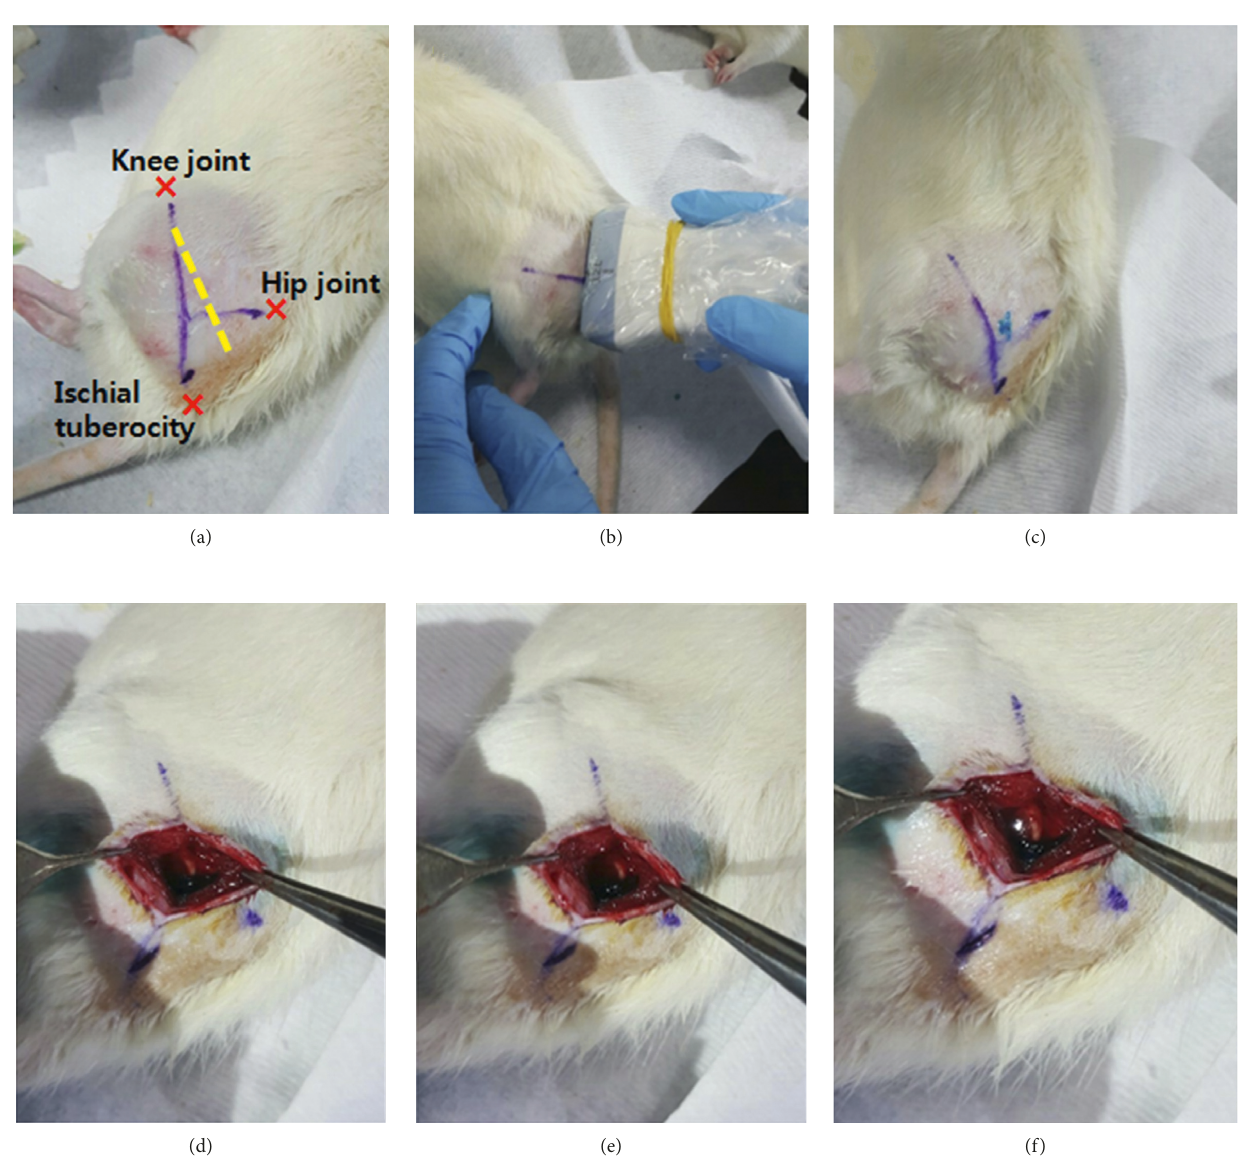
Figure 2: Perineural dexmedetomidine injection under ultrasound guidance. (a) Expected path of sciatic nerve marked with yellow dotted line. The sciatic nerve runs between the hip joint and the ischial tuberosity toward the knee joint. (b) Sciatic nerve detection by placement of probe obliquely or vertically on expected course. An image of the nerve as detected via ultrasound is shown in Figure 1. (c) Blue dye injection using same volume of DXM (0.08 ml) in experiment. The entry point is indicated by the blue spot. (d–f) A series of photographs of post-blue-dye-injection. After incising the skin between hip joint and ischial tuberosity and dissecting fascia and muscle, blue dye is visible around the sciatic